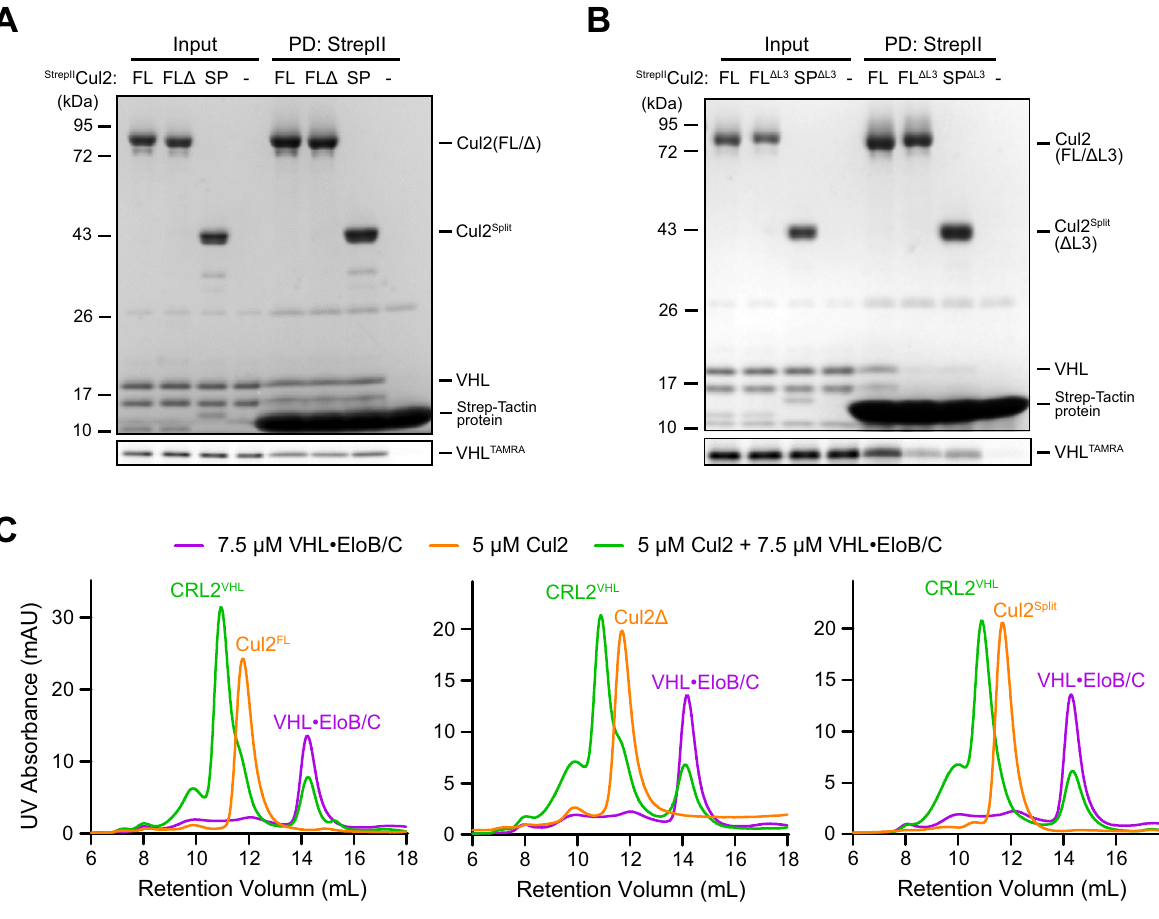
Figure 3. Interactions between the purified RBX1•CUL2 proteins and VHL•EloB/C. ( A-B ) StrepII-tag affinity pulldown assays for the formation of CRL2 VHL complex when different types of RBX1•CUL2 is present. In each assay, 2 µM VHL•EloB/C or VHL TAMRA •EloB/C was incubated with 1 µM each type of RBX1•CUL2. The input and pulldown samples were fractionated on SDS-PAGE, scanned for TAMRA signal, and stained with Coomassie Blue. FL: RBX1• StrepII CUL2 FL ; FLΔ: RBX1• StrepII CUL2Δ; SP: RBX1• StrepII CUL2 Split ; ΔL3: Leucine 3 of CUL2 deleted. ( C ) Chromatograms showing gel filtration elution peaks of 7.5 µM VHL•EloB/C (purple), 5 µM indicated version of RBX1•CUL2 (orange), and mixtures of 7.5 µM VHL•EloB/C and 5 µM RBX1•CUL2 (green). The same trace for VHL•EloB/C was used in all three plots. Based on the reduction of the VHL•EloB/C peak area, percentage of RBX1•CUL2 assembled into CRL2 VHL complex was estimated as 79% for CUL2 FL , 82% for CUL2Δ, and 83% for CUL2 Split . Protein species under the main peaks were confirmed by SDS-PAGE (Fig.